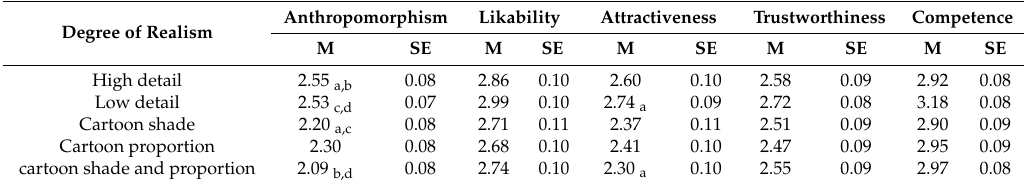
Table 9. Means of person perception for realism.